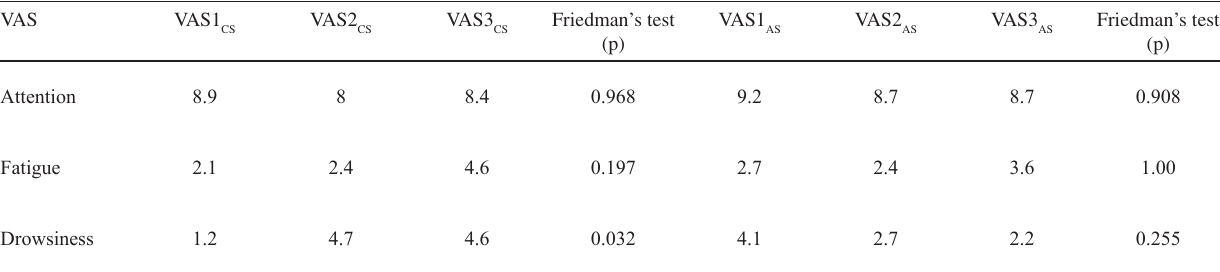
Table 3 - Visual Analog Scales (VAS) scores at the beginning of the experiment (VAS1), before somatosensory stimulation (VAS2) and after somatosensory stimulation (VAS3) in the control (CS) and active (AS) conditions. p values for the Friedman´s test are shown. Wilcoxon tests showed significant differences in drowsiness between VAS1 between VAS1 and VAS3 (p=0.015) but not between other measurements CS CS